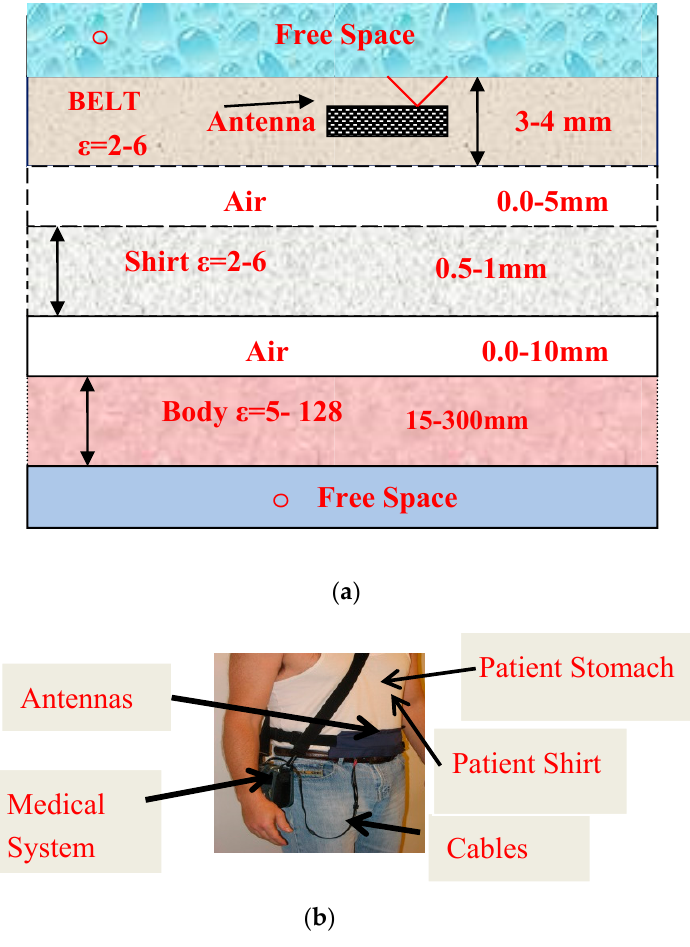
Figure 24. ( a ) Wearable Antenna environment; ( b ) Wearable Medical System. Table 5. Electrical properties of body tissues [16,17].